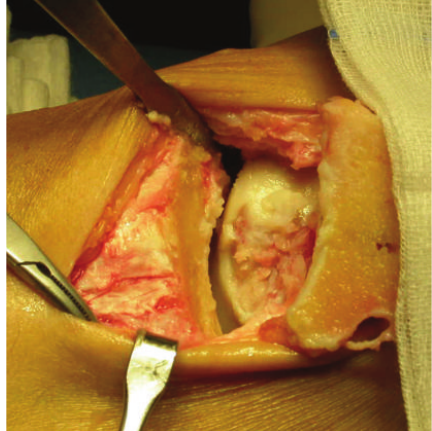
Figure 3: A medial malleolar osteotomy with subsequent fixation of the osteotomy with 1 screw was required in 3 cases to approach in a posteromedial osteochondral lesion of the talus, not suitable by arthroscopy.